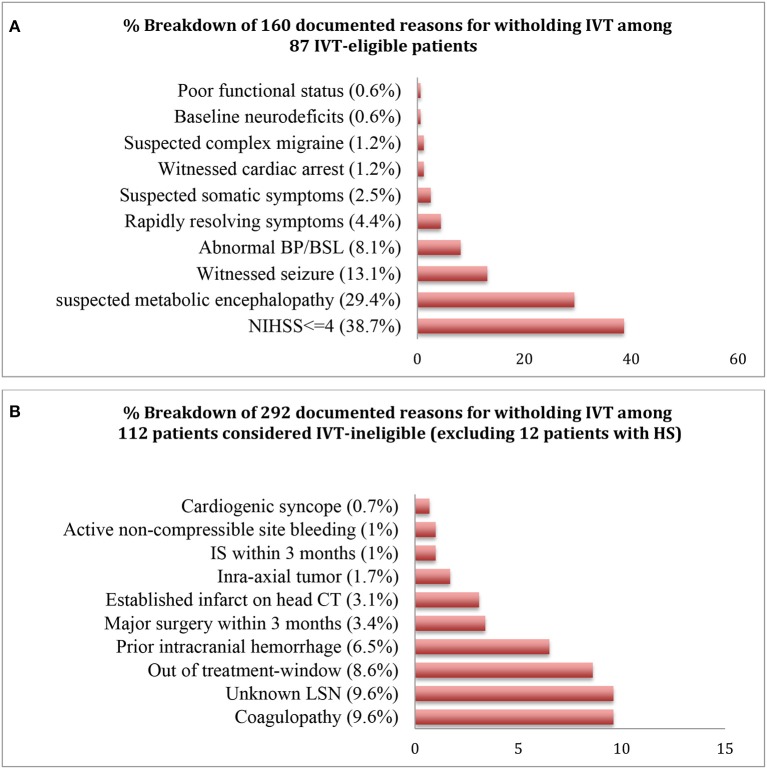
Percentage distributions of the documented reasons for withholding IVT in the IVT-eligible (A) and ineligible (B) cohorts.